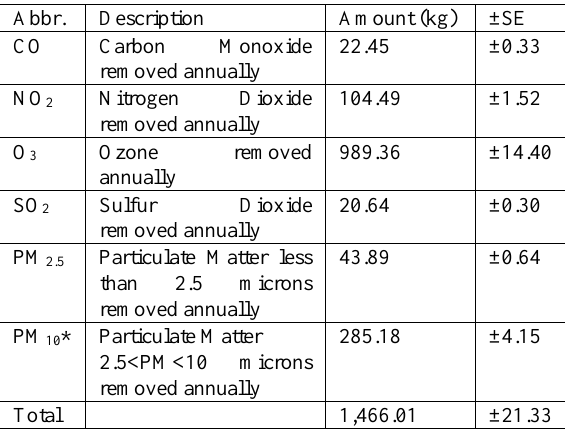
Table 2 . Contribution of Uncalı cemetery to ecosystem services